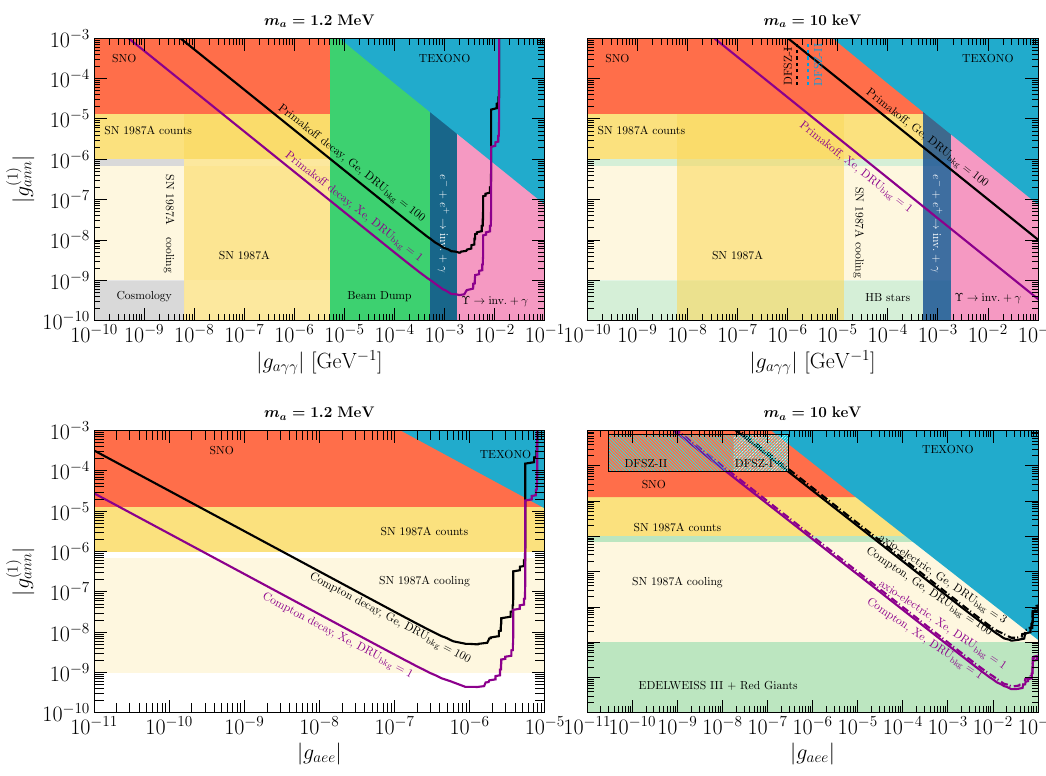
Figure 13 . 90%CL sensitivities in ALP production through magnetic de-excitation and detection through g and g related processes. Results are displayed in the couplings plane for a fixed ALP aγγ aee mass. See text for more details. Bounds on the isovector axion-nucleon coupling g (1) from [131]. For completeness we include the region of DFSZ-I and DFSZ-II QCD axion